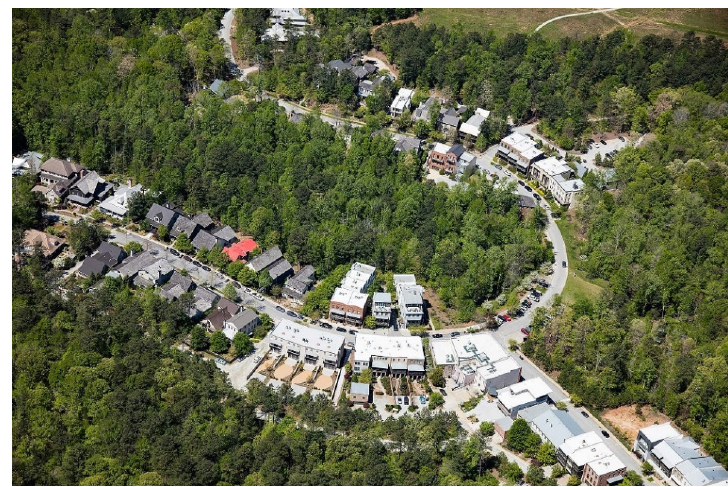
Figure 2. Arial view of Selborne hamlet in the Serenbe community. Source: Serenbe Development.